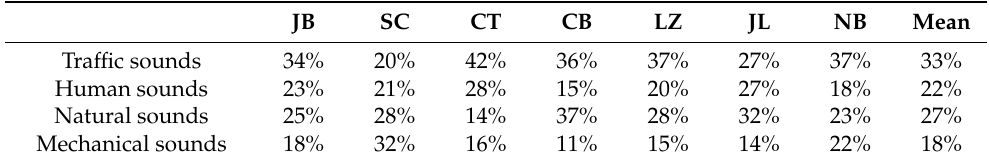
Table 3. Proportions of traffic sounds, human sounds, natural sounds, and mechanical sounds in seven WSMCs.